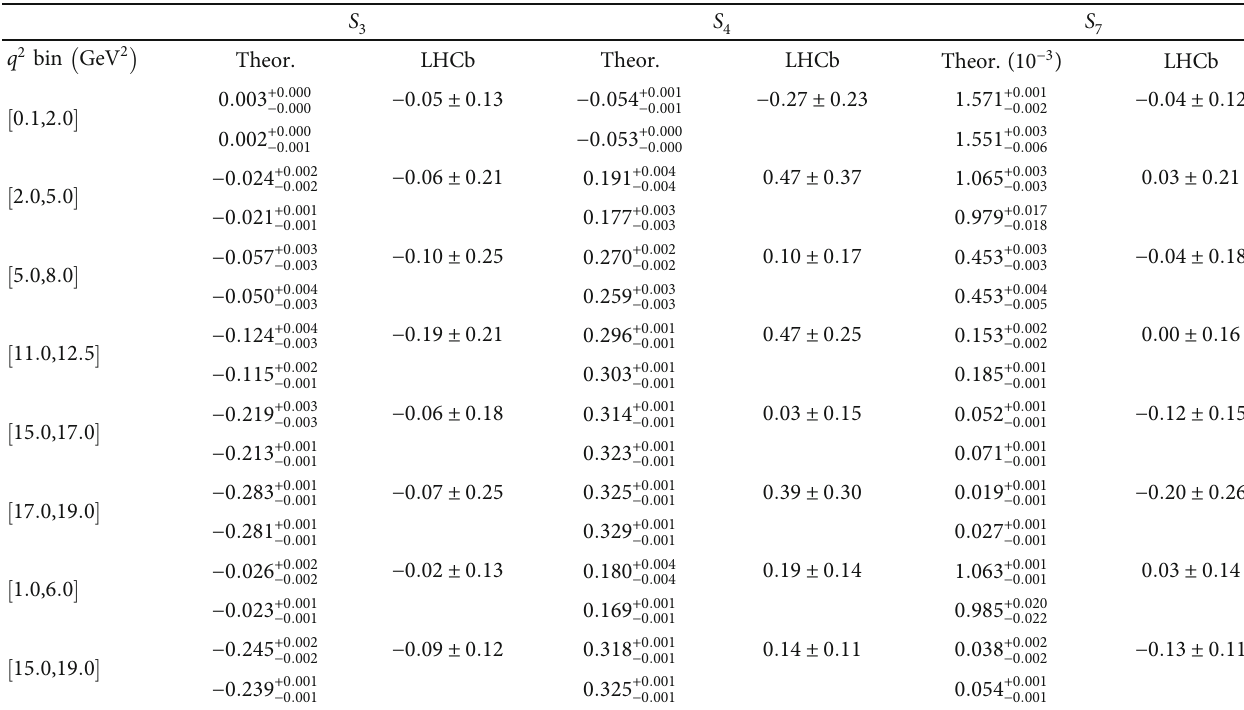
⟶ ϕμ + μ − in the PQCD (the fi rst low) and “ PQCD Table 10: Theoretical predictions for the q 2 -binned observables S 3,4,7 of the decays B s +Lattice ” (the second row) approaches. For a comparison, we also list the LHCb measured values [31]. S 3 S 4 S 7 Theor. LHCb Theor. LHCb Theor. ( 10 − 3 )